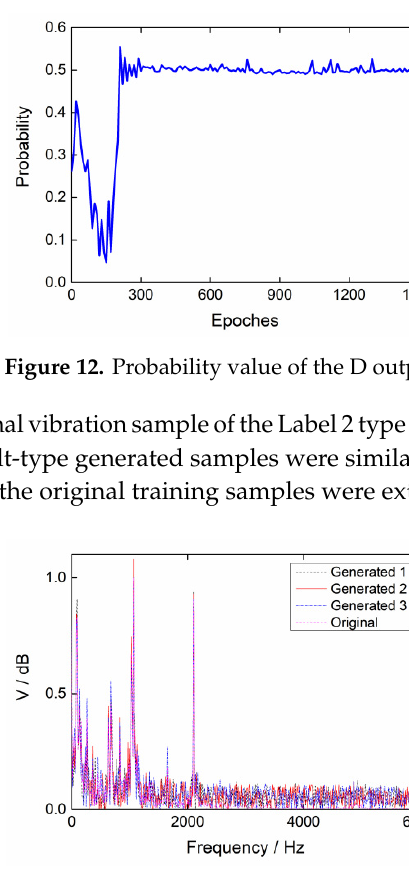
Figure 13. Original and generated samples.